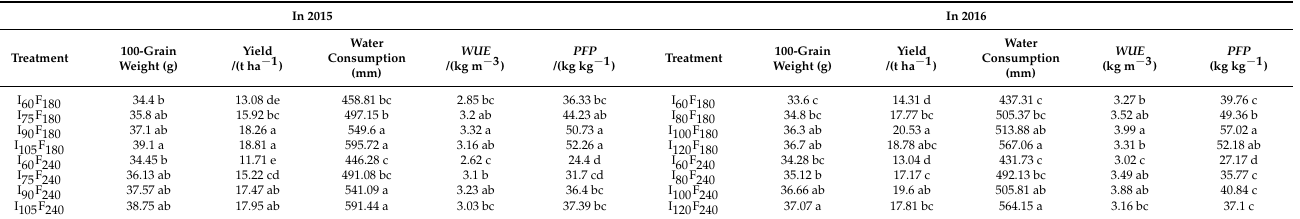
Table 3. The 100-grain weight, yield, water consumption, WUE and PFP under different irrigation and fertigation treatments in 2015 and